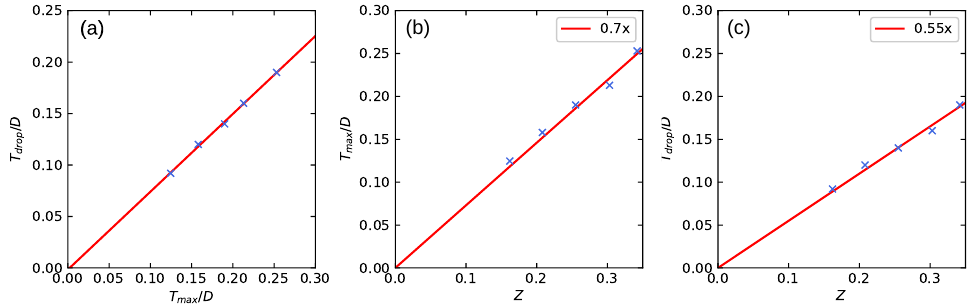
Figure 11. ( a ) T drop as a function of T max . ( b ) T max as a function of Z . ( c ) T drop as a function of Z